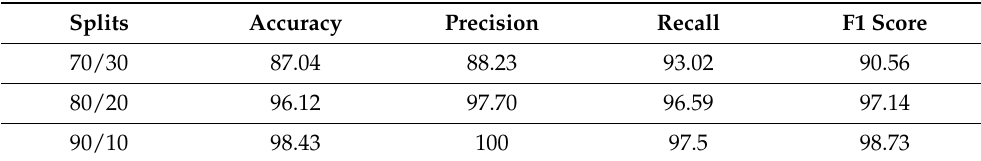
Table 6. Arabic Fake News Classification results of Mini-Bert-based Transfer Learning Classifiers using various data splits Splits Accuracy Precision Recall F1 Score